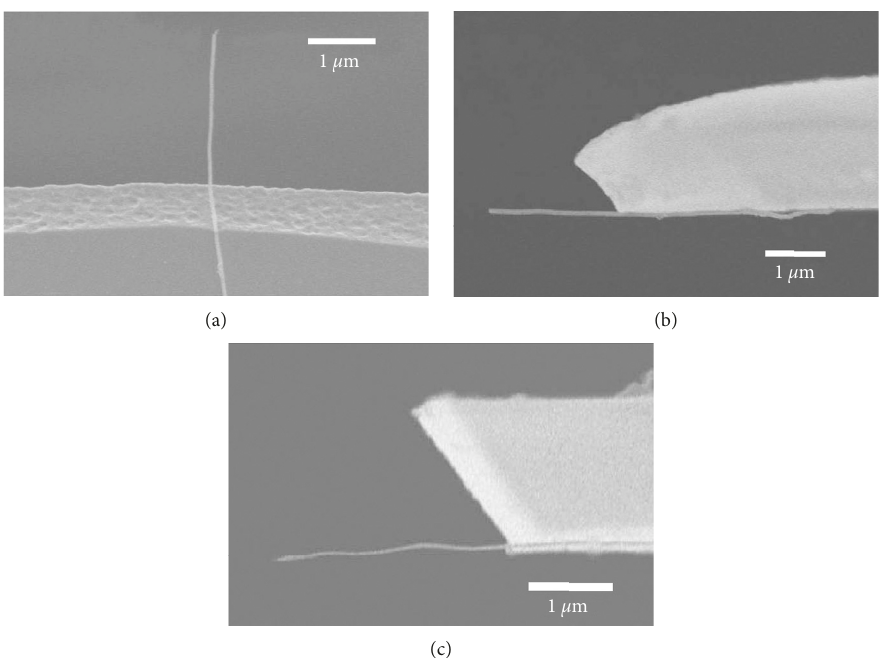
Figure 6: Scanning electron microscopy images of the (a) bottom and (b) side of a peeling atomic force microscope probe with a length of 2.2 μ m and of the (c) side of a peeling atomic force microscope probe with a length of 2.5 μ m. The individual carbon nanotube used to attach such probes is 10 ± 2nm in inner diameter and 40 ± 6 nm in outer diameter, respectively (adapted with permission from reference [104]; copyright 2009, Elsevier